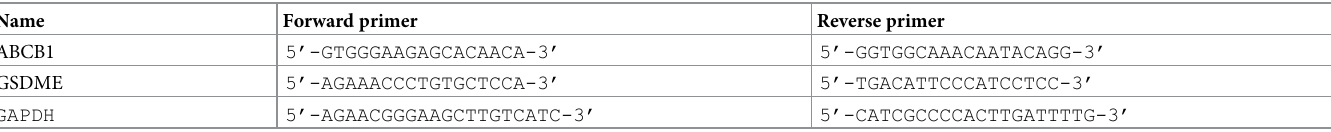
Table 1. Polymerase chain reaction (PCR)